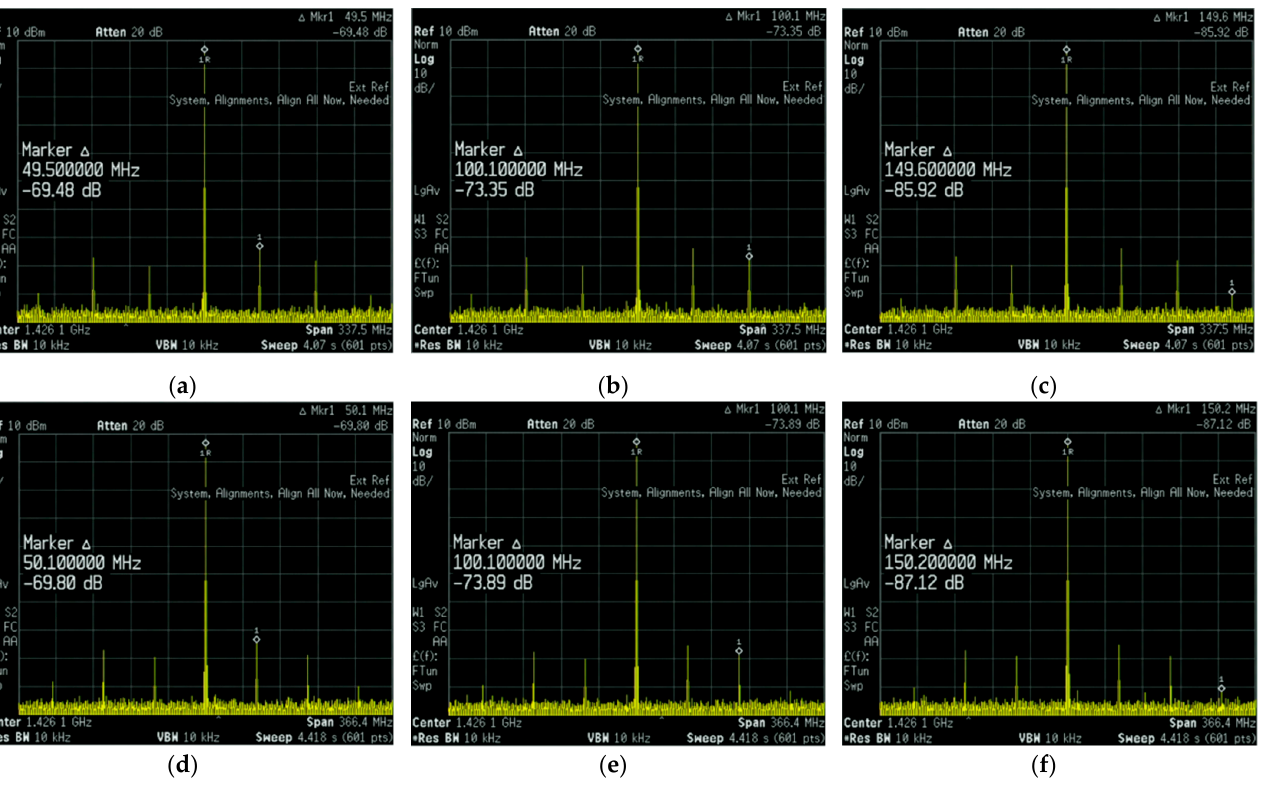
Figure 11. Spur suppression: ( a – c ) passive fourth-order RC filter and ( d – f ) passive fourth-order RLC filter.